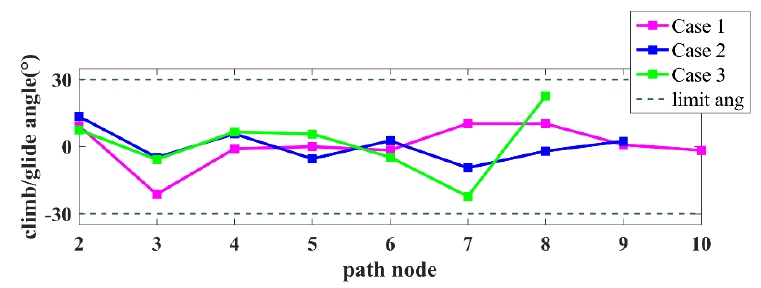
Figure 6. Turning angle of path nodes in three different cases.